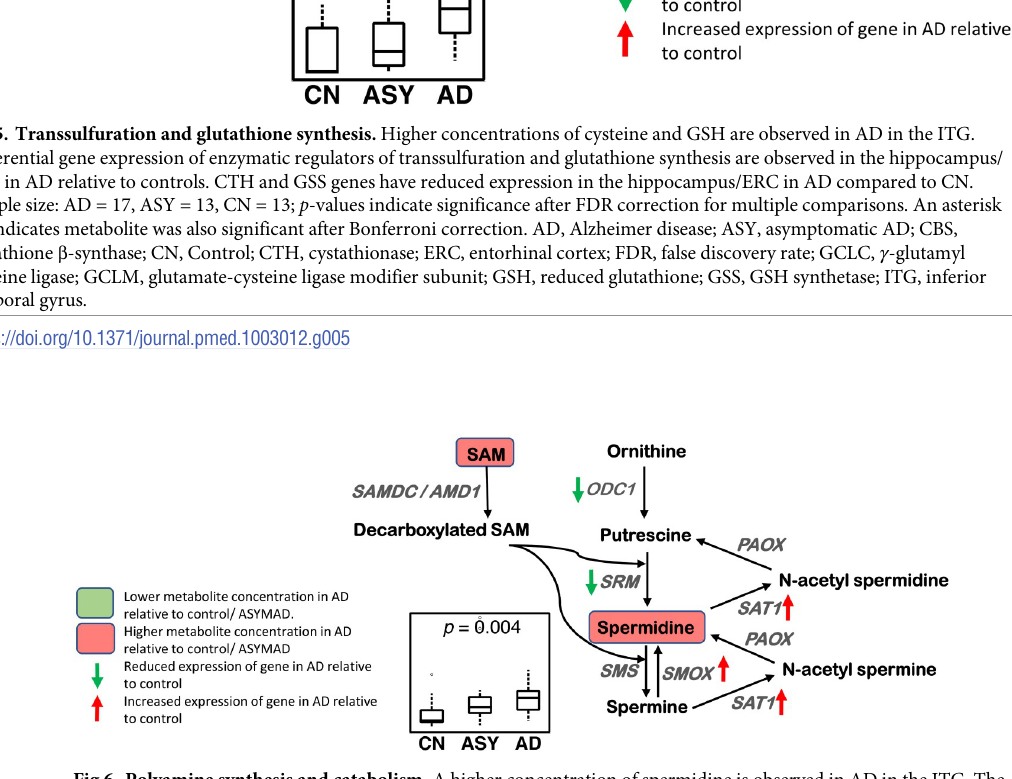
Fig 6. Polyamine synthesis and catabolism. A higher concentration of spermidine is observed in AD in the ITG. The polyamine catabolic genes SAT1 and SMOX have increased expression, and the polyamine synthesis genes SRM and ODC1 have reduced expression in the hippocampus/ERC in AD compared to CN. Sample size: AD = 17, ASY = 13, CN = 13; p -values indicate significance after FDR correction for multiple comparisons. AD, Alzheimer disease; ASY, asymptomatic AD; CN, Control; ERC, entorhinal cortex; FDR, false discovery rate; ITG, inferior temporal gyrus; ODC1, ornithine decarboxylase 1; PAOX, peroxisomal N(1)-acetyl-spermine/spermidine oxidase; SAM, S-adenosyl methionine; SAMDC/AMD1, S-adenosylmethionine decarboxylase proenzyme/adenosylmethionine decarboxylase 1; SAT1, spermidine/spermine N1-acetyltransferase 1; SMOX, spermine oxidase; SMS, spermine synthase; SRM, spermidine synthase.